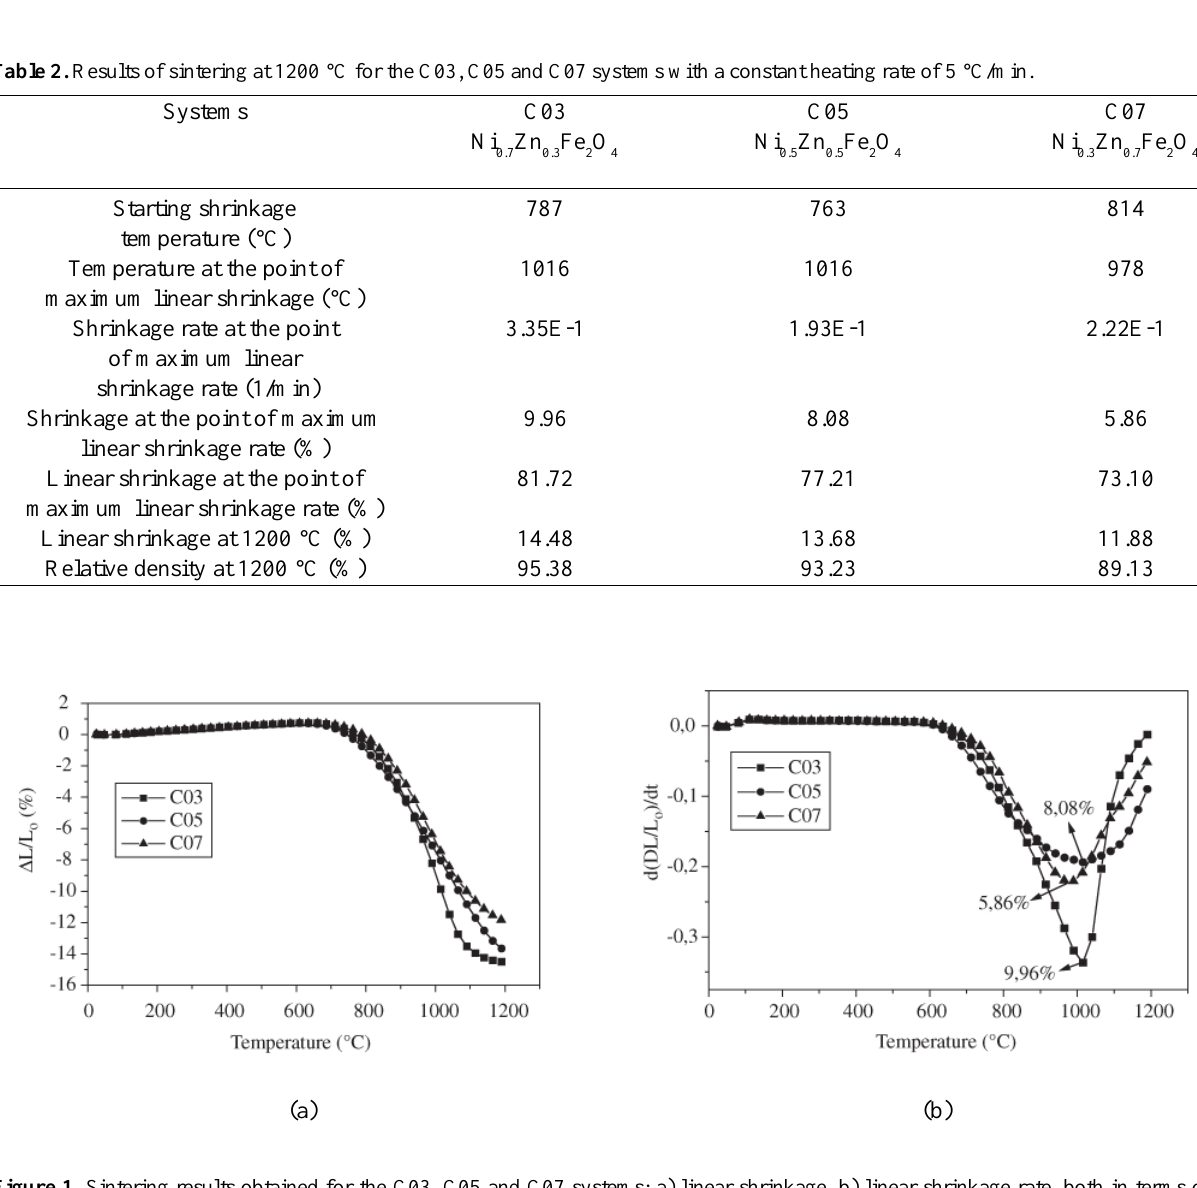
Figure 1. Sintering results obtained for the C03, C05 and C07 systems; a) linear shrinkage, b) linear shrinkage rate, both in terms of temperature, with a constant heating rate of 5